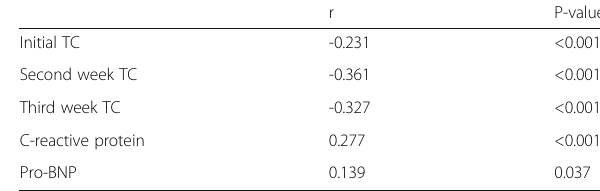
Table 78 (abstract A249). Correlation analysis with APACHE IV score